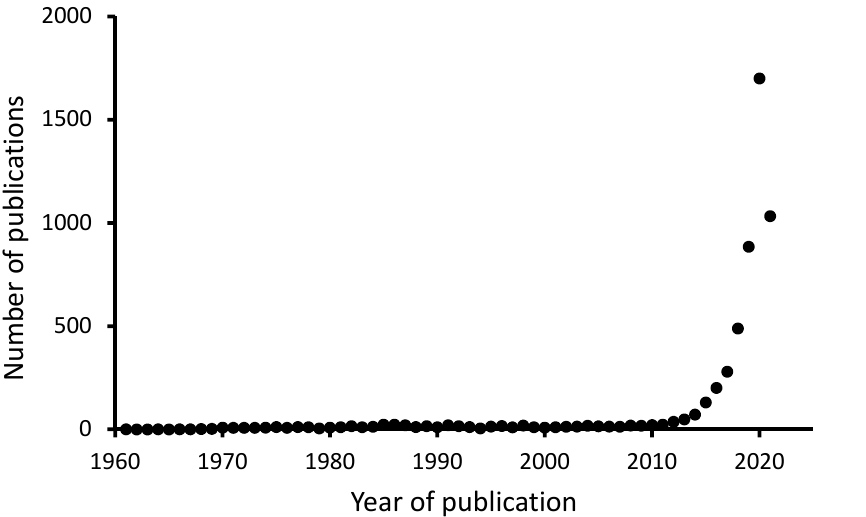
Figure 1. Number of papers published from 1961 to 3 May 2021 in Scopus database with microplastic